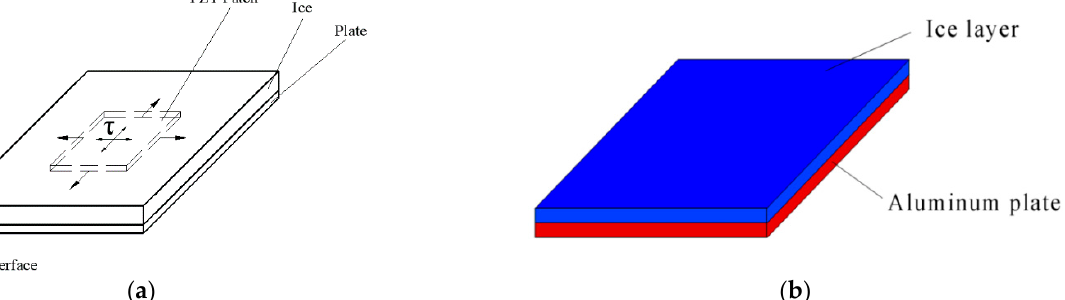
Figure 3. Model of iced plate element for ultrasonic deicing: ( a ) principle of ultrasonic deicing; ( b ) model of iced aluminum alloy plate.